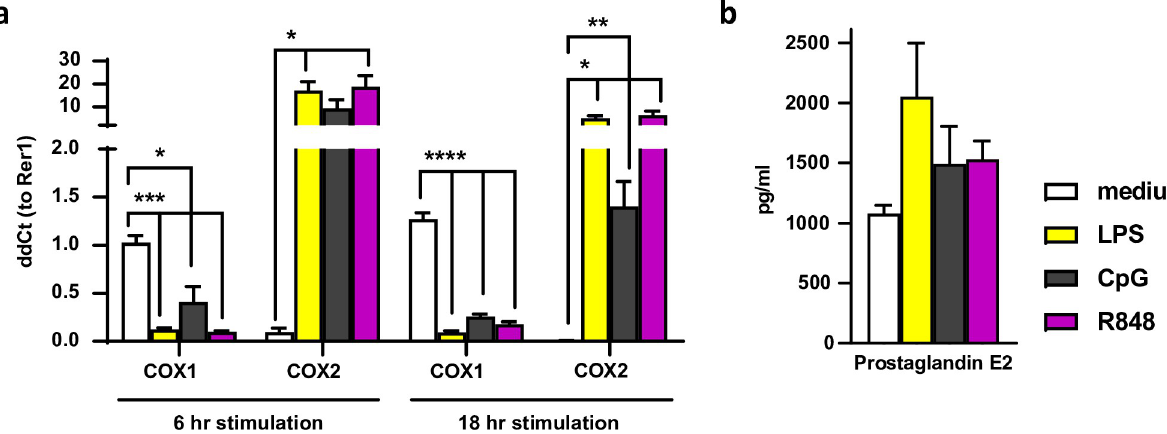
Fig 1. COX expression and PGE2 production upon TLR exposure. mBMDCs were treated for 6 hr (a) and 18 hr (a, b) with the TLR adjuvants LPS, CpG, and R848. (a) RT-QPCR was performed for mRNA expression of COX1 and COX2 (mBMDCs, n = 6). (b) PGE2 was measured using a competitive enzyme immunoassay in PCA-treated supernatant (n = 3). Results are shown as means with SEM. Statistical significance was calculated using a one-way ANOVA with Dunnett’s multiple comparison test, medium versus rest.